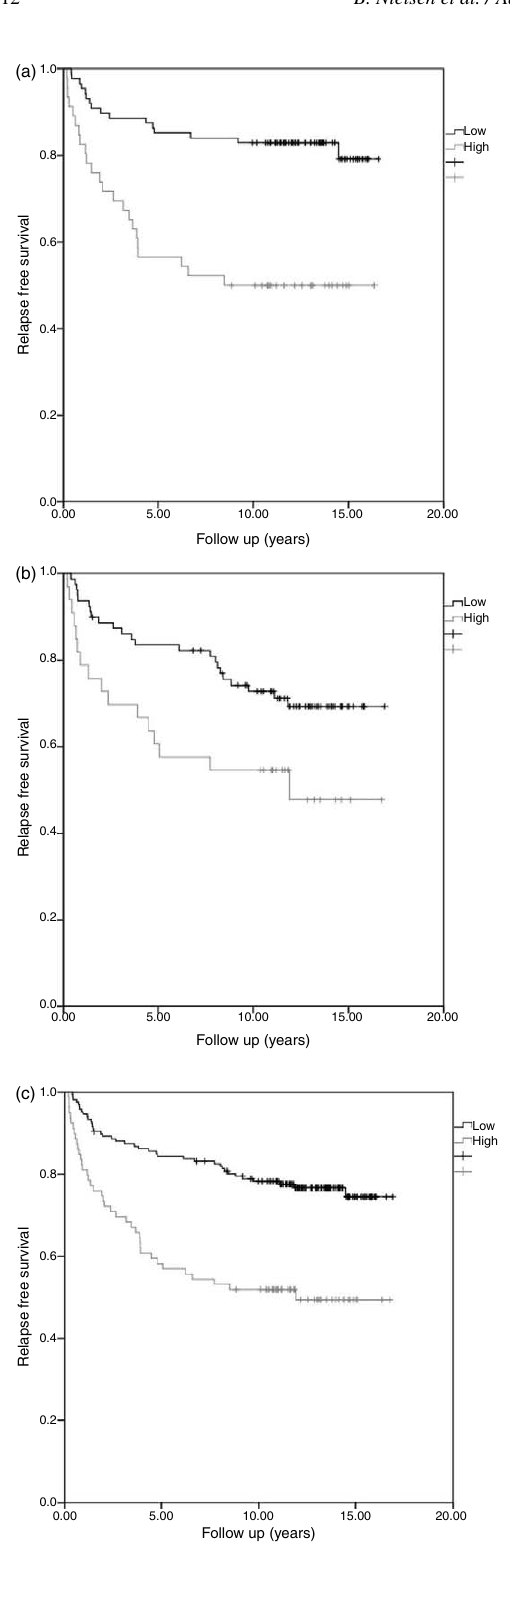
Fig. 3. Kaplan-Meier survival curves based on the adaptive feature AF − computed from the 2D entropy matrices. Survival curves are shown for (a) the learning set, (b) the validation set and (c) the complete data